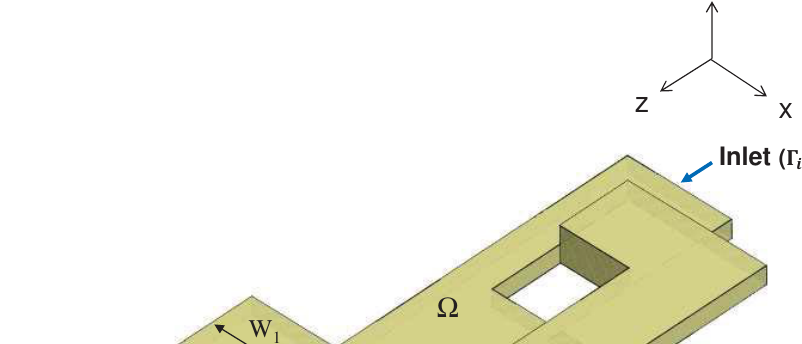
Figure 1. A channel geometry of the chaotic serpentine mixer that consists of “L-shaped” structures and bypass channels, leading to two counter-rotating flow portraits. Overall streamline portraits are shown at the lower-right corner of the figure. The arrows represent the direction of the rotational flows viewed from the exit of the channel. Here, W is the 1 width of the “L-shaped” channel, W the width of the bypass channel and H the height of 2 one layer of the channel. The length of one period is L = 8 W 1